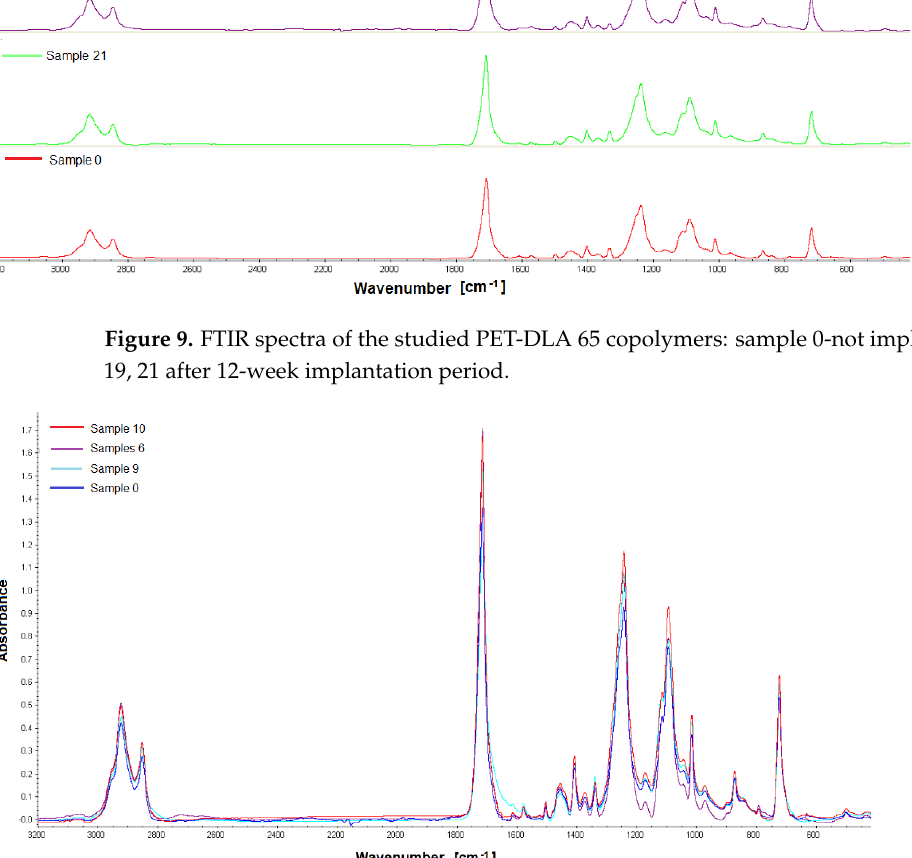
Figure 10. FTIR spectra of the studied PET-DLA 70 copolymers: sample 0-not implanted, sample 6, 9, 10 after 12-week implantation period.